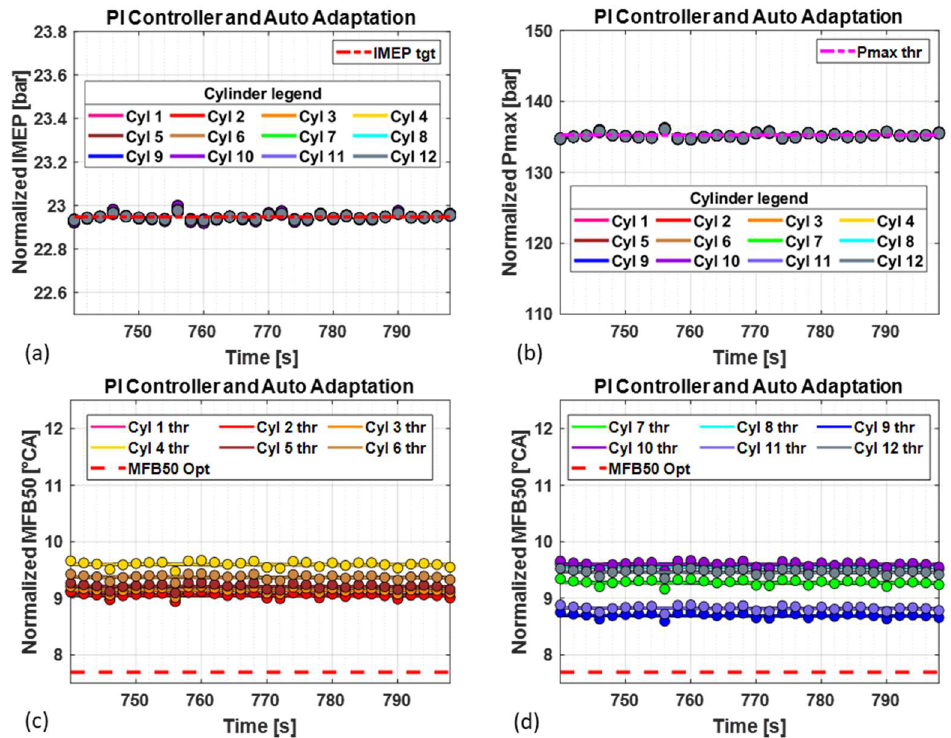
Figure 15. Comparison between desired and actual values of combustion metrics produced by all the 12 cylinders when all the strategies are active at 1800 rpm and 100% pedal: ( a ) IMEP, ( b ) Pmax, ( c ) MFB50 of cylinders 1–6, ( d ) MFB50 of cylinders 7–12.